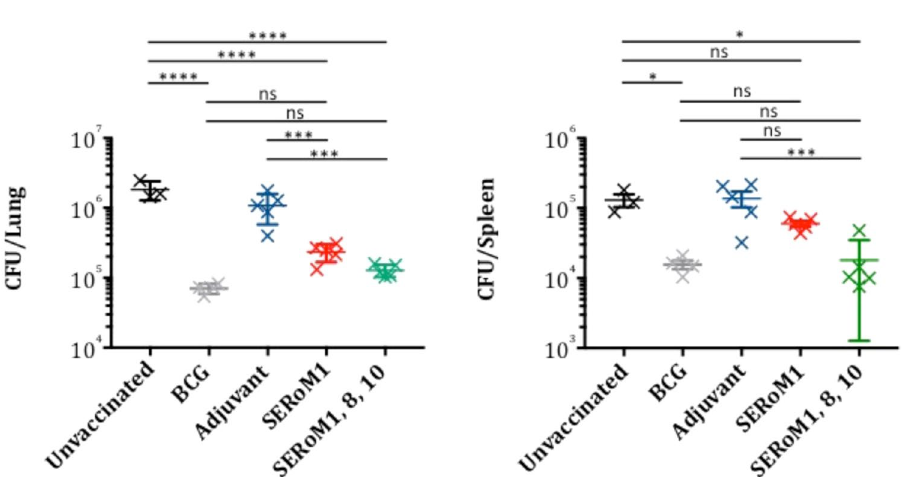
Figure 4. Protective effects of SERoM vaccines in mice. C57BL/6 Mice (n = 5) were vaccinated subcutaneously three times with SERoM vaccines, adjuvanted with DDA/MPLA. Mice were subsequently aerosol challenged with M. tuberculosis H37Rv 6 weeks post third vaccination. ( A ) protection in the lung of vaccinated mice. ( B ) protection in the spleen of vaccinated mice. Crosses are individual mice with mean and standard deviation shown. Significance was calculated compared to relevant control group via one-way ANOVA with Tukey’s multiple comparisons test. * p < 0.05, *** p < 0.005, **** p ≤